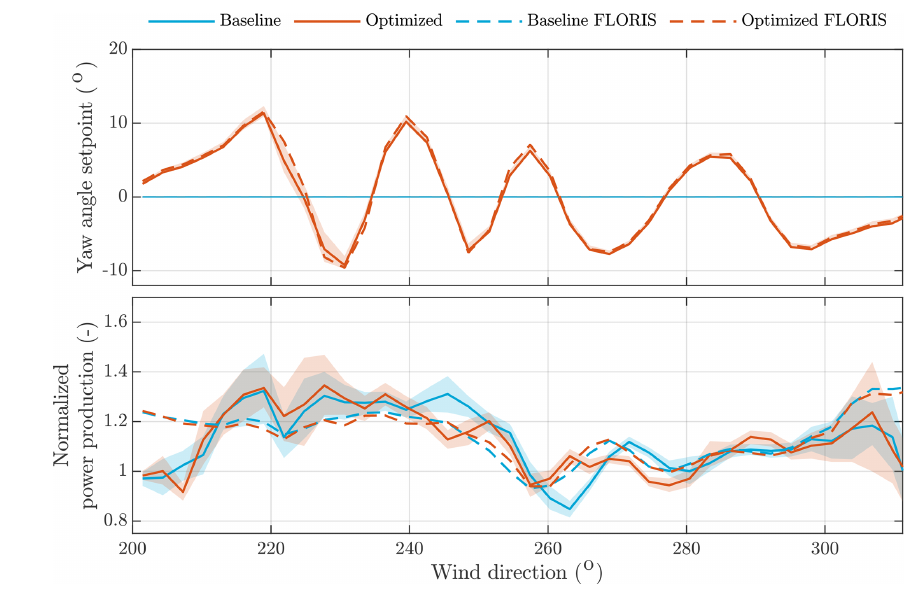
Figure 9. Yaw misalignments and power production for WTG E5, normalized with respect to WTG 25. The shaded areas show the 95% confidence bounds. The dashed lines represent the predictions for the measured inflow conditions by FLORIS. The number of samples in each bin is shown in Fig.